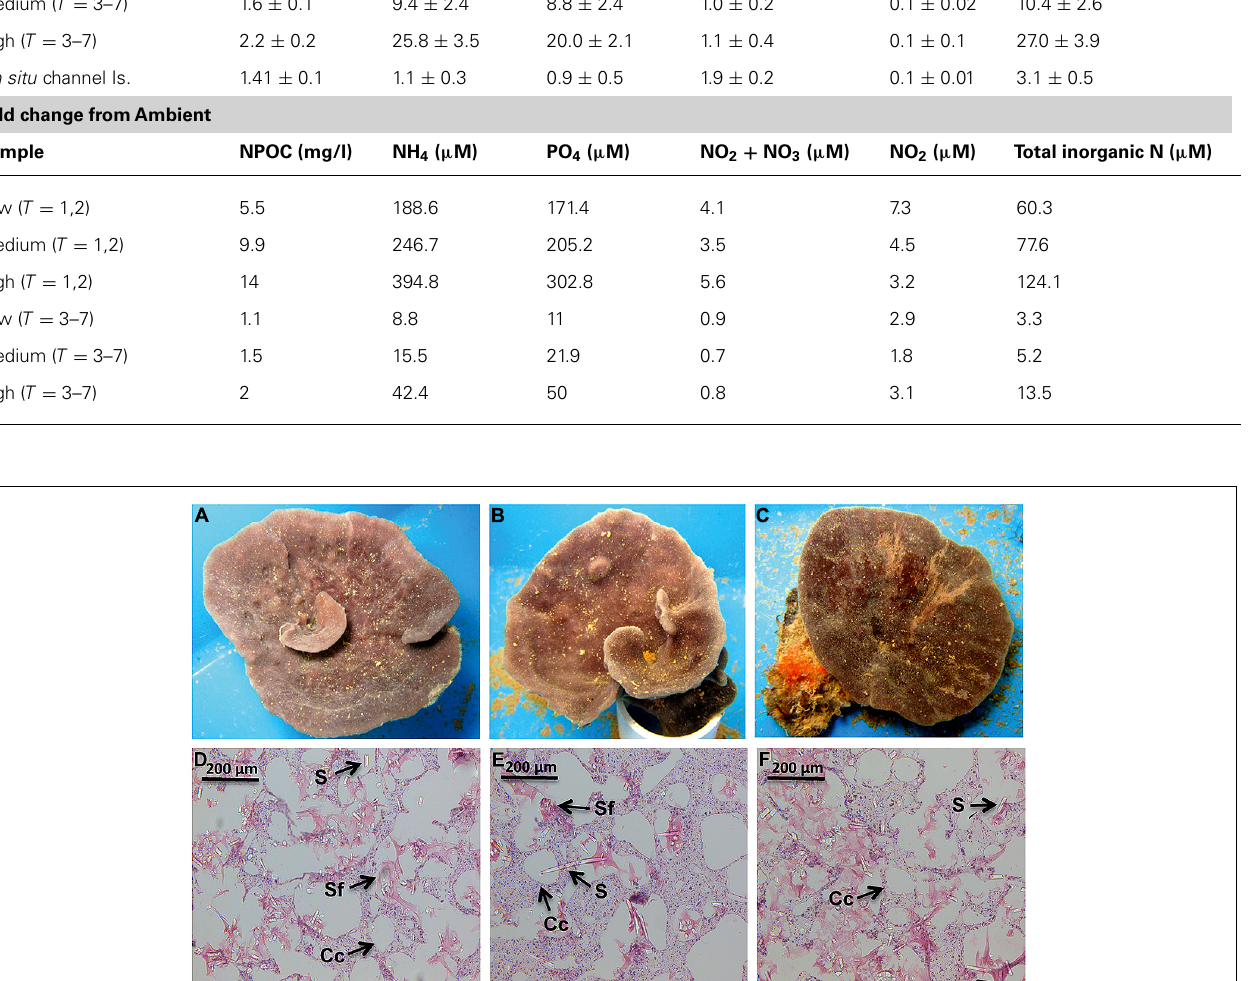
All samples shared 40% similarity in community composition and no particular groupings according to nitrogen treatment were evident. The DNA-derived community was not signif- icantly different between nutrient treatments (PERMNOVA, p = 0.075). PCO of the OTUs from RNA-derived samples also showed no distinctive clustering of samples according